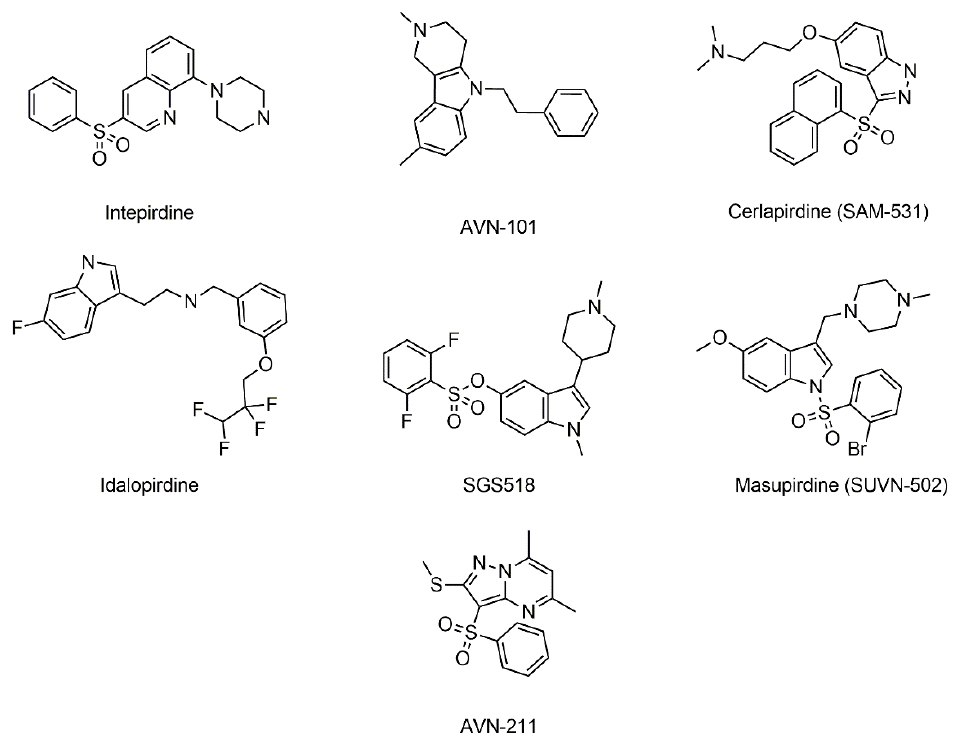
Figure 2. Structural formula of 5HT6 receptor ligand from literature. After PCA virtual screening, we selected ten of the most similar compounds to the learning set from each EIIP/AQVN range, which was further subjected to molecular docking. The data on PCA model are available in Supplementary Materials. Furthermore, after the docking process, we selected ten best candidates (Table 2, Figure 3) based on their docking score, i.e., the best balance between calculated free binding energy and favorable and non-favorable protein-ligand interactions. Table 2. List of the best candidate compounds for 5HT6 receptor, based on their docking